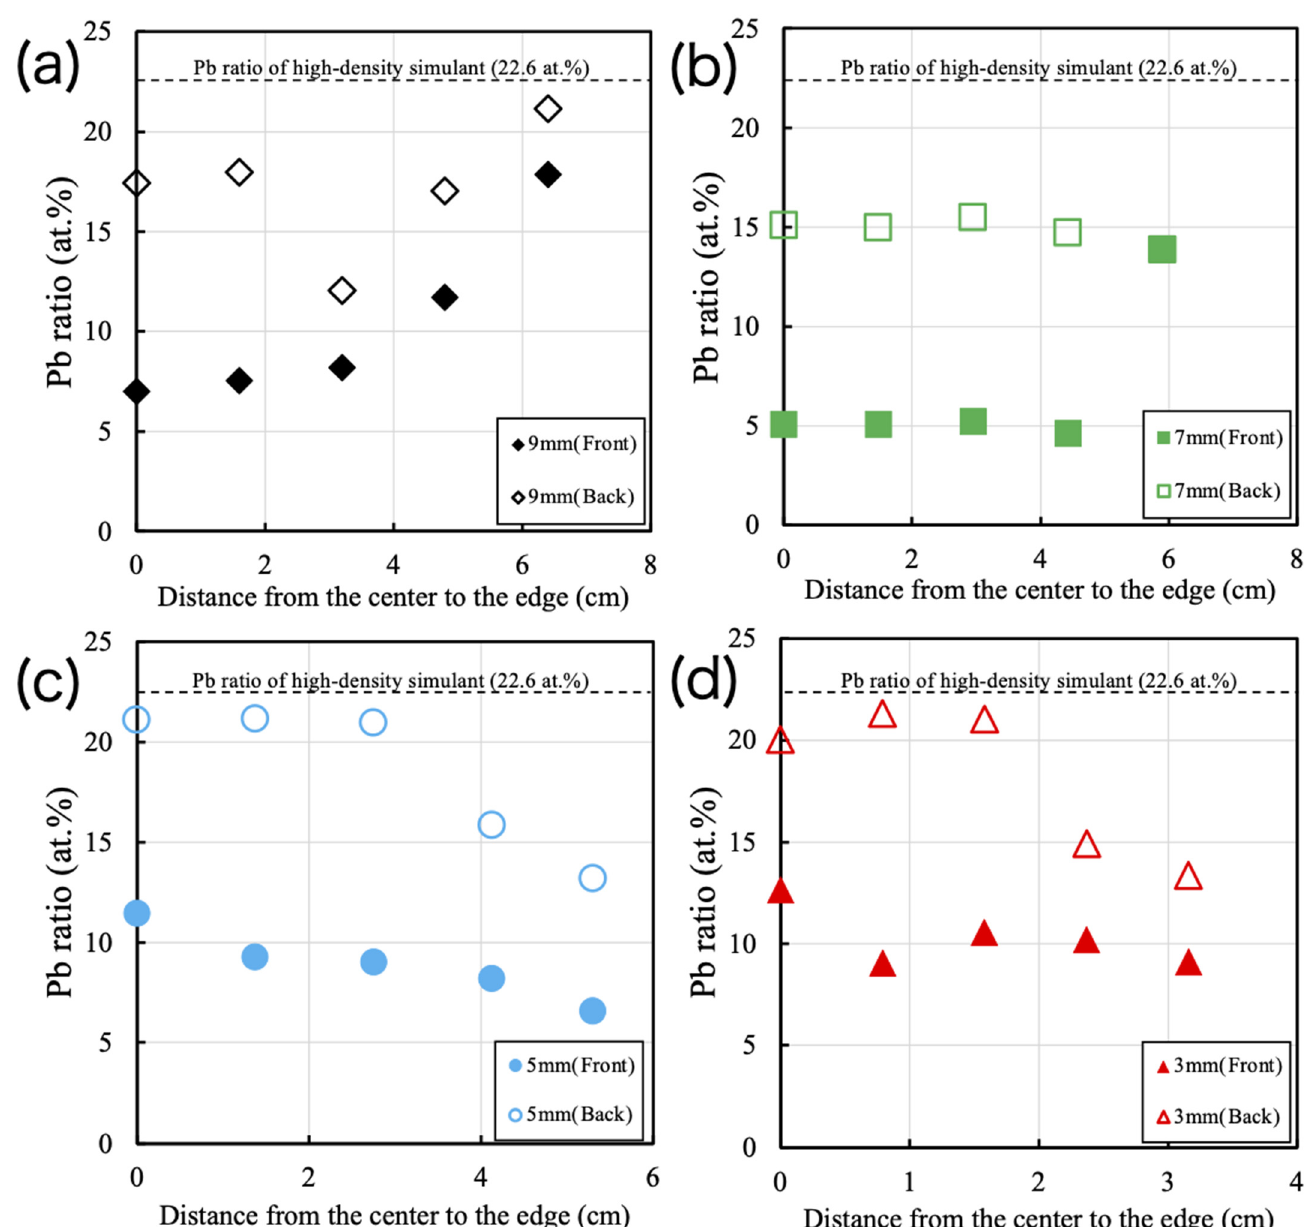
Figure 6. Pb distribution in the solidified metal under the density stratification ( a ) 9 mm outlet, ( b ) 7 mm outlet, ( c ) 5 mm Figure 8. Pb distribution in the solidified metal under the reverse density stratification ( a ) 9 mm outlet, ( b ) 7 mm outlet, ( c ) 5 mm outlet, ( d ) 3 mm outlet. outlet, ( d ) 3 mm